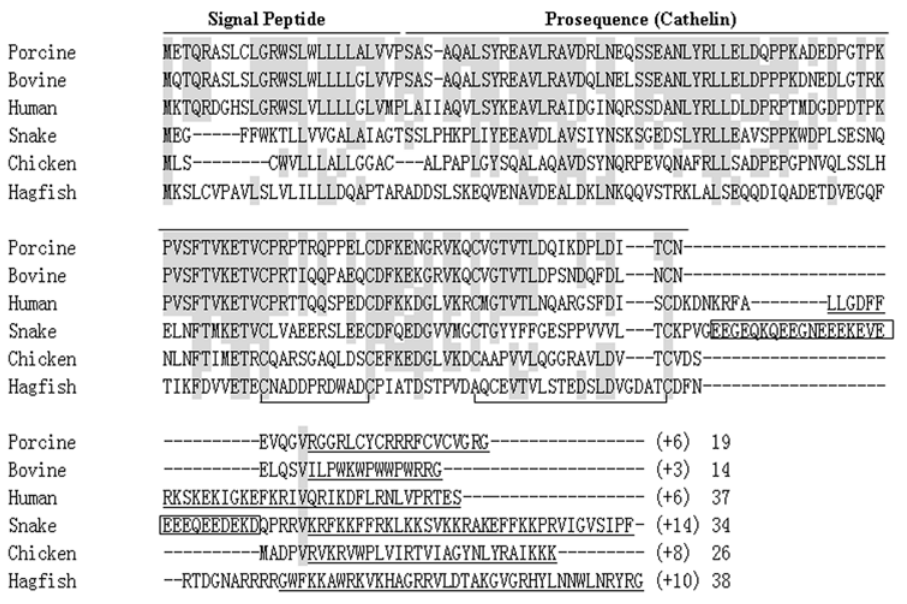
Figure 2. Multiple sequence alignment of snake cathelicidin with other representative cathelicidins. Cathelicidin-BF precursor is aligned with porcine, bovine, human, chicken and hagfish cathelicdins. Dashes are inserted to optimize the alignment, and conserved residues are shaded . Two intramolecular disulfide bonds in the cathelin pro-sequence are shown. Mature cathelicinds are underlined , and their net charge ( in parenthesis ) and length are also indicated. The acidic fragment insertion in cathelicidin-BF is boxed .